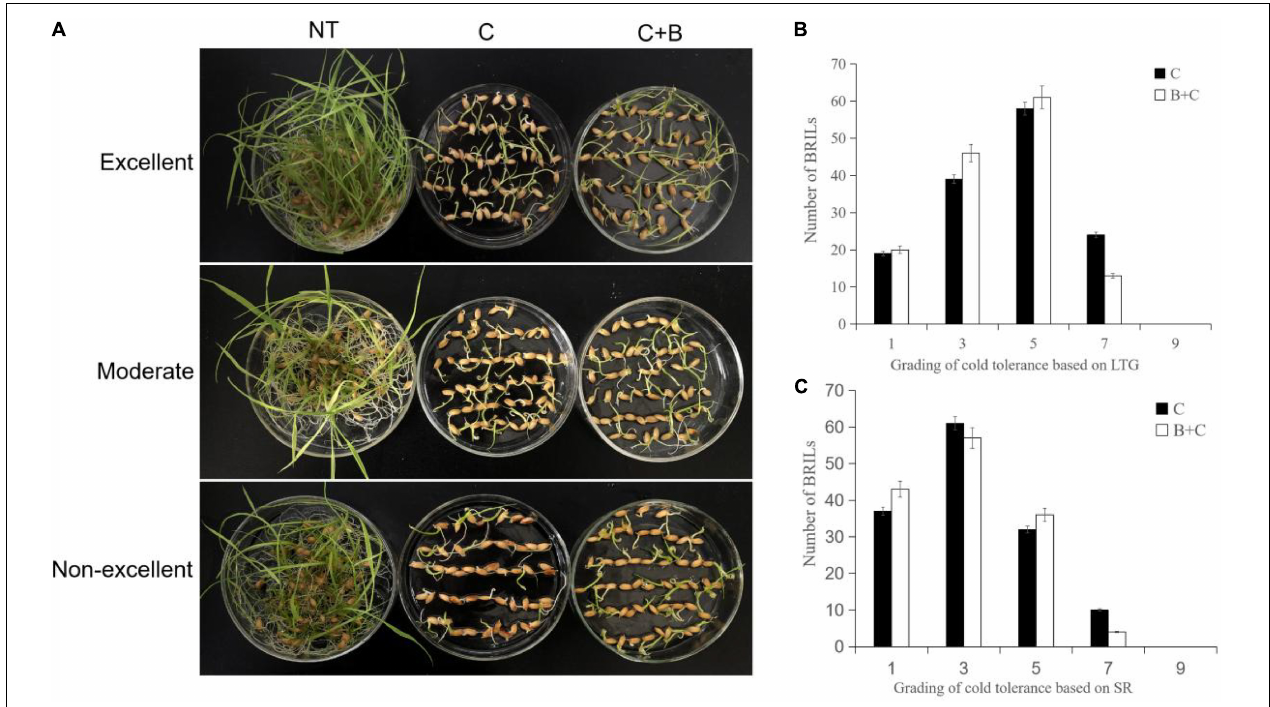
FIGURE 1 | Phenotypic characterization under cold stress and BR-combined cold treatment at the germination stage in BRILs. (A) Phenotypes of the representative BRILs with excellent, moderate, and non-excellent cold tolerance. (B) Grading of cold tolerance based on LTG. (C) Grading of cold tolerance based on SR. LTG,